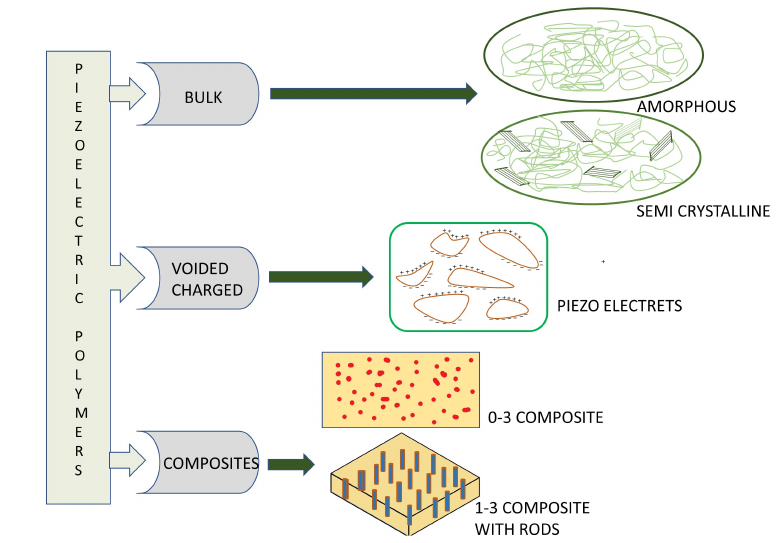
Figure 2. Classification of piezoelectric polymers: bulk piezo polymers, voided charged polymers or piezoelectrets and piezoelectric polymer